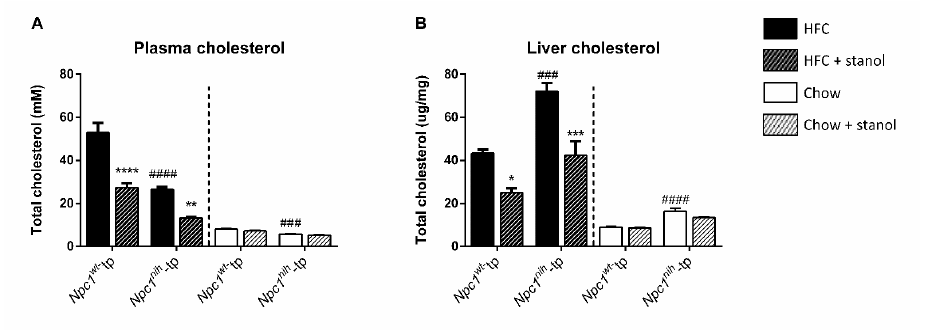
Figure 2. Plasma and liver lipid levels: HFC and chow diets. ( A ) Total plasma cholesterol levels and ( B ) total liver cholesterol levels. n = 6–8 mice per group. All error bars represent standard error of the mean. Statistical significance is indicated as follows: Npc1 nih - tp mice on an HFC or chow diet vs. Npc1 wt - tp mice on an HFC or chow diet (### p < 0.001; #### p < 0.0001); Npc1 wt - tp or Npc1 nih - tp on a HFC or chow diet vs. Npc1 wt - tp or Npc1 nih - tp mice on a plant stanol-enriched HFC or chow diet (* p ≤ 0.05; ** p < 0.01; *** p < 0.001; **** p < 0.0001). Biomedicines 2021 , 9 , x FOR PEER REVIEW